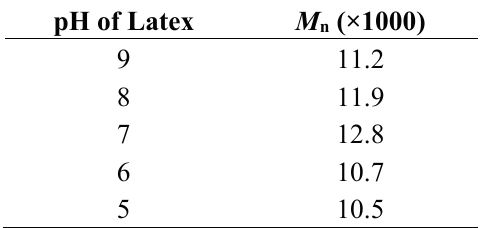
Table 3. Number average molecular weight ( M n ) of LNR samples prepared at different